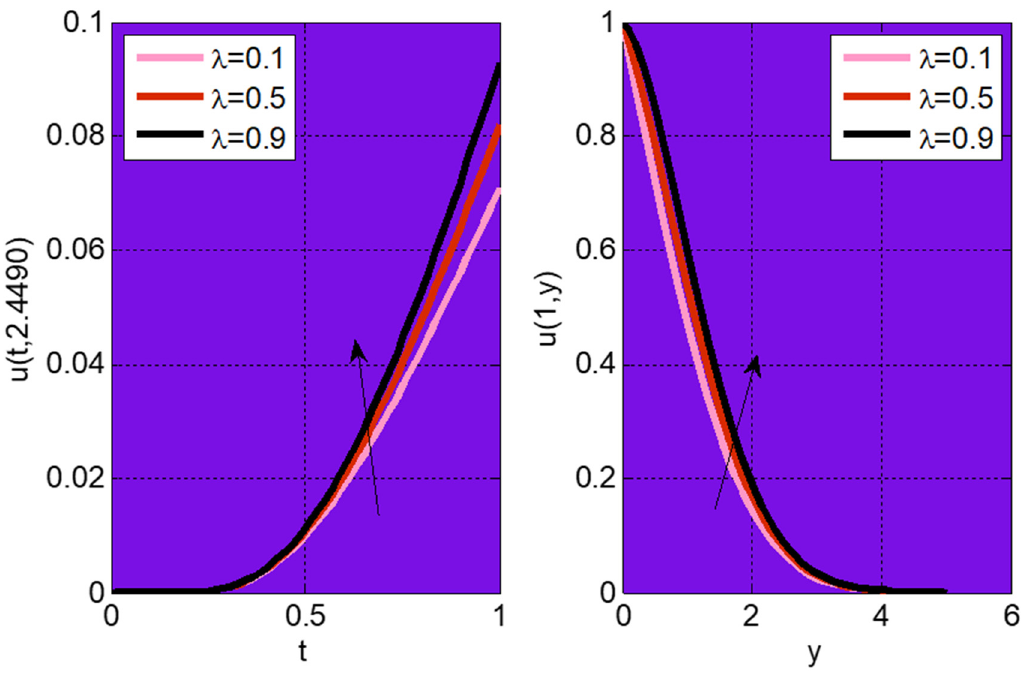
Figure 8. Impact of λ on velocity profile of Stokes’ first problem in Quantum Calculus by the proposed scheme for spatial direction and Crank–Nicolson scheme for time direction using q = 0.8,